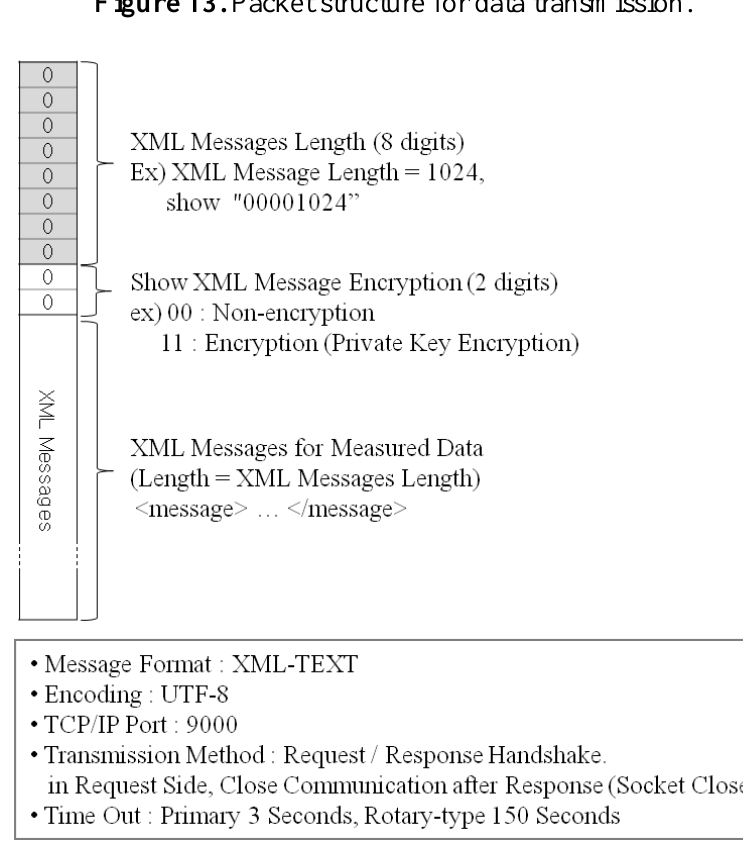
Figure 13. Packet structure for data transmission.